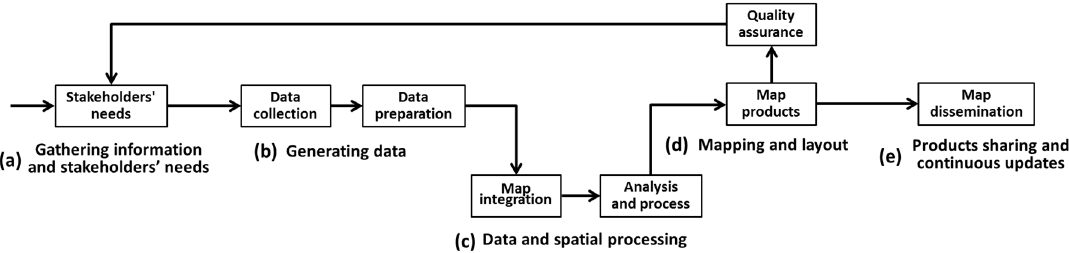
Figure 5. Workflow of emergency mapping team (EMT) operations.